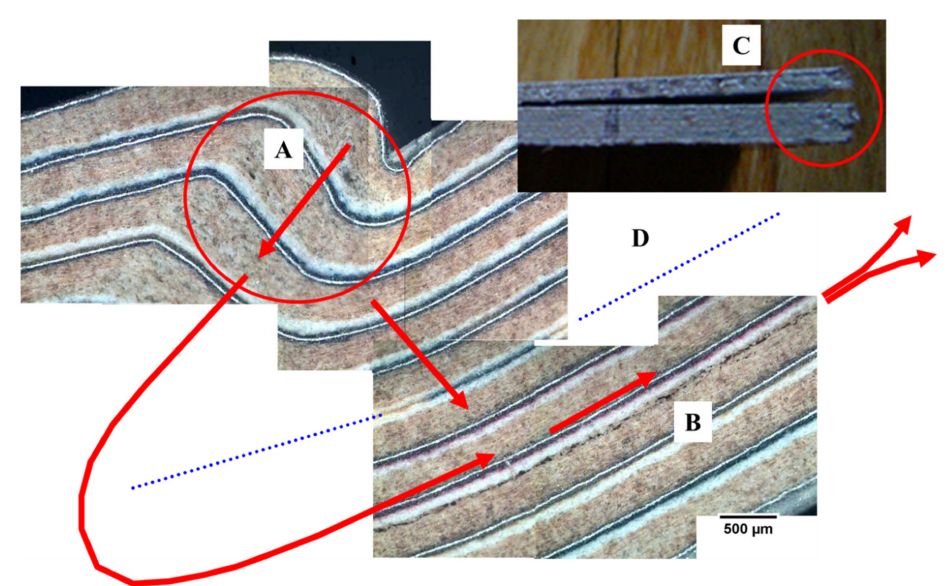
Figure 20. General mechanism of failure in flexion of the multilayer sample of G1 series. ( A ) Generation of a lack of cohesion-defibrillation zone of the cellulose with progression to the centre of the board. ( B ) Lack of cohesion of the interface between PE and cellulose, the weakest zone of the board. The interface PE–PE or neutral layer ( D ) of the centre of the board remains intact (in all the tests) and the stress is transferred to the second or third sheet from surface board. ( C ) Macrograph of the part with the delamination in the third sheet, interface PE–cellulose.